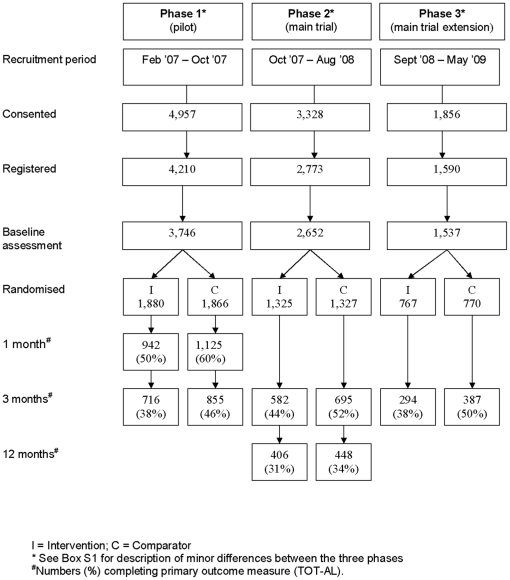
CONSORT diagram.